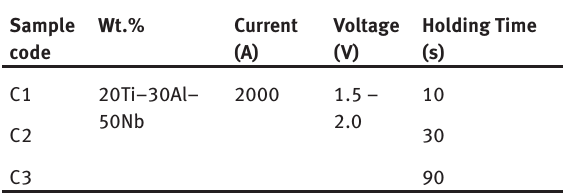
Table 1: Process Parameters.